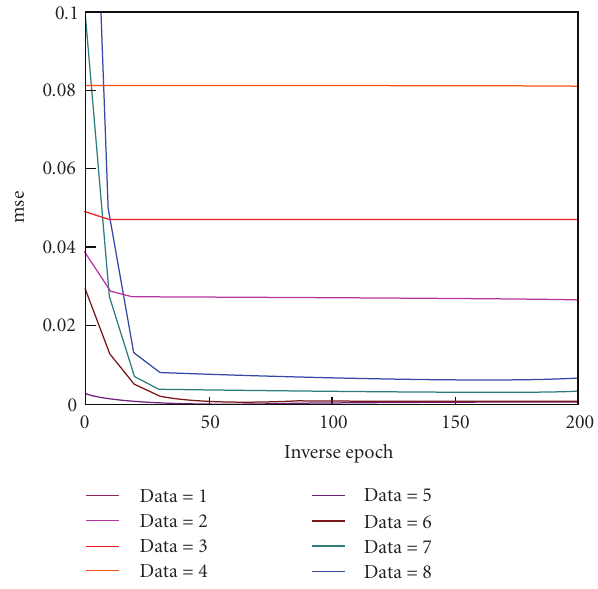
Figure 9: Error curves of inverse estimation for each estimation